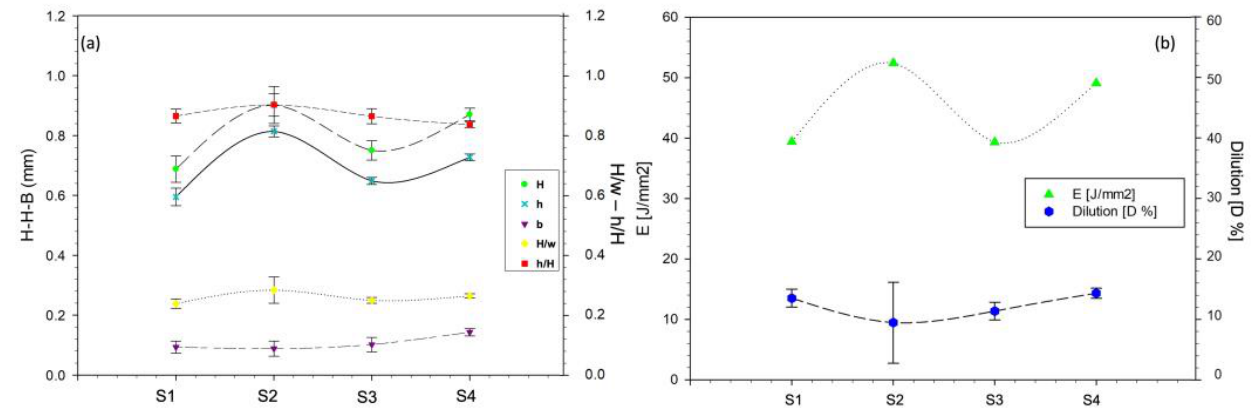
Figure 4. ( a ) Geometrical features of the cross-sections and ( b ) laser energy input ( E ) values against dilution ( D ) for each set.